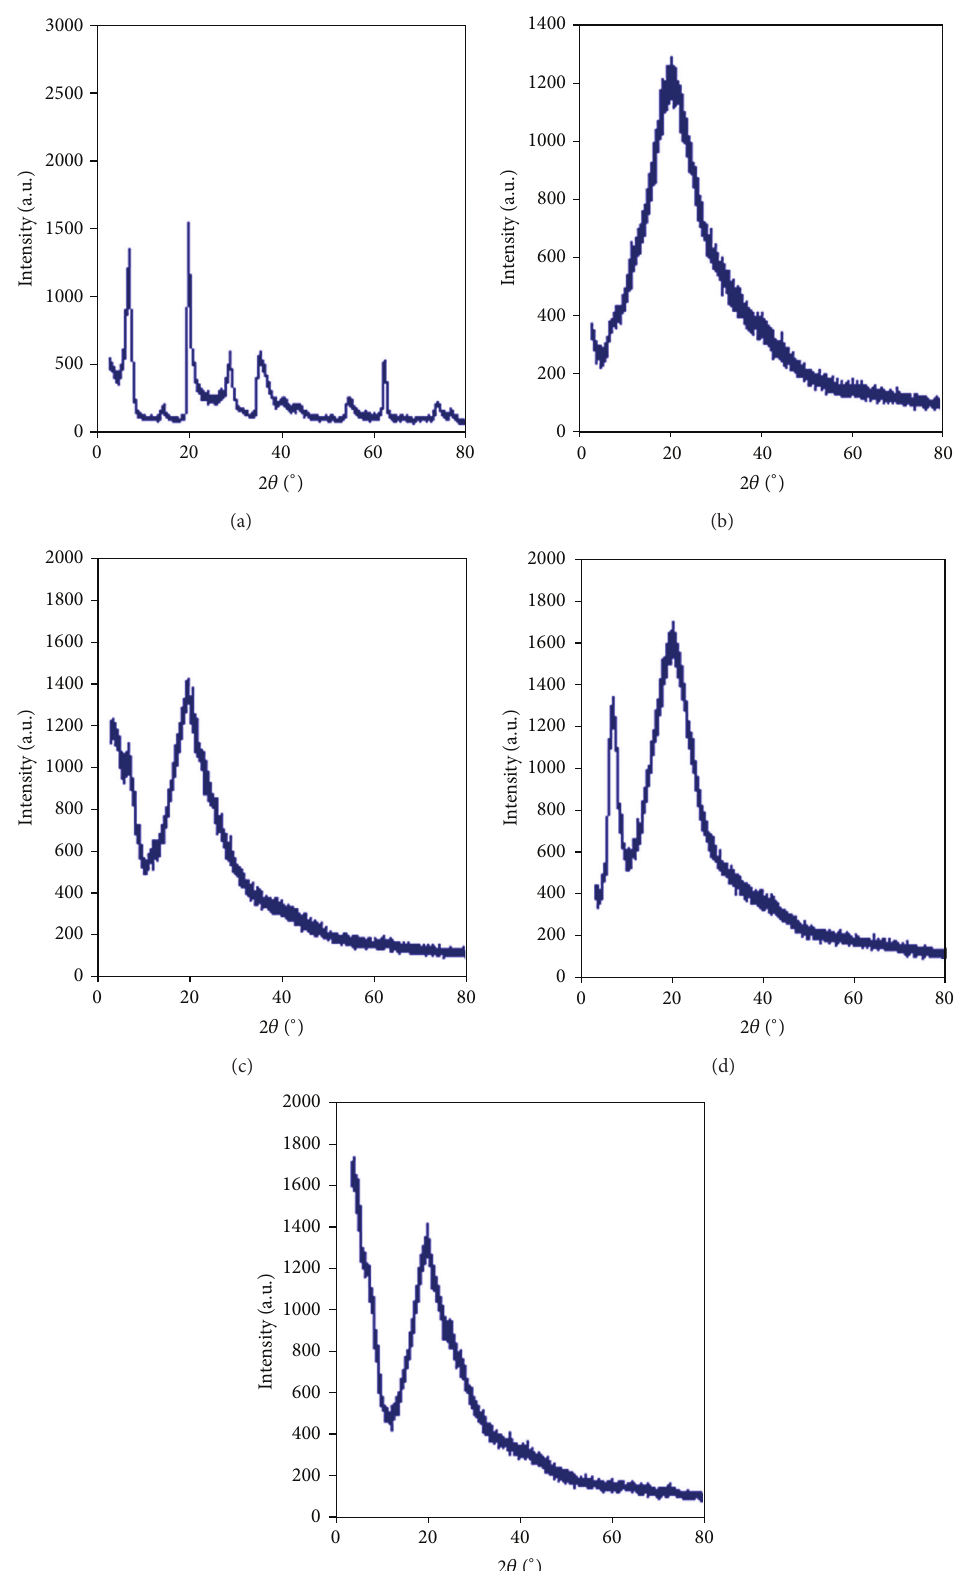
Figure 3: X-ray diffractograms of MMT (a), of gelatin (b), and of 5% gelatin-based nanocomposites with (c) 0%, (d) 5%, and (e) 10% of